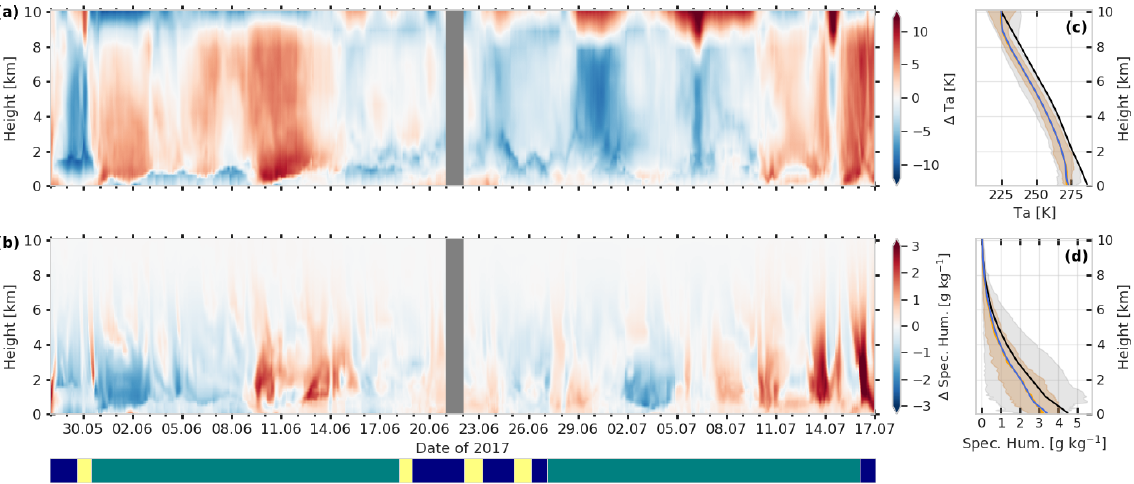
Figure 3. Time–height plot of atmospheric profiles obtained along the PS106 cruise track. (a) ERA5 atmospheric temperature anomalies. (b) ERA5 specific humidity anomalies. (c) Mean profiles of atmospheric temperature and (d) mean profiles of specific humidity for ERA5 (orange) and radiosondes (blue). The sub-Arctic summer standard atmosphere (Anderson et al., 1986) is displayed in black. The grey-shaded area indicates the minimum and maximum values, while the brownish-shaded area shows the interquartile range of the ERA5 profiles. The lower coloured band indicates the times when Polarstern was located in open ocean (blue), the marginal sea-ice zone (yellow) and in mostly sea ice (teal).